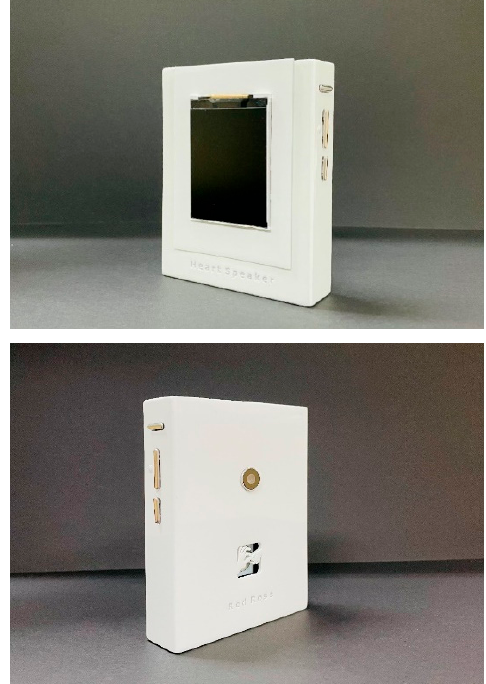
Figure 4. Physical map of Heart-Speaker.